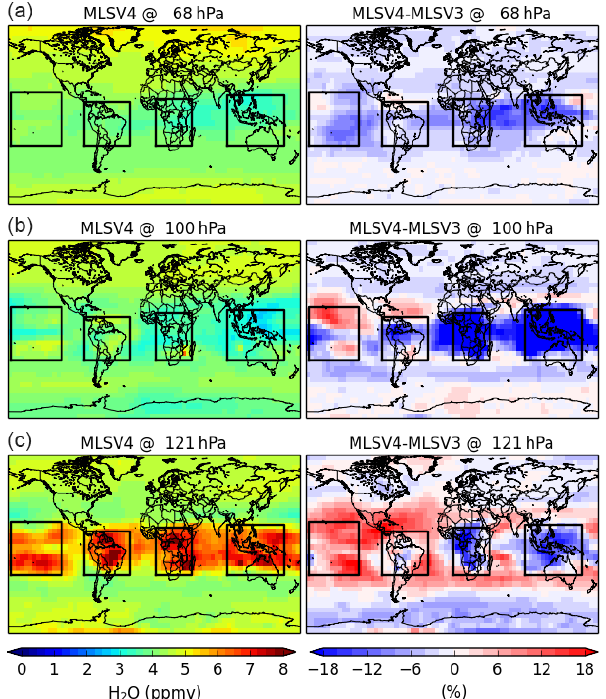
Figure 19. Monthly averaged H 2 O analyses in the model space in January 2012 using the MLS V4 data set (left) and relative differ- ence between the MLS analyses using V4 and V3 data sets (right) at 121hPa (c) , 100hPa (b) and 68hPa (a)